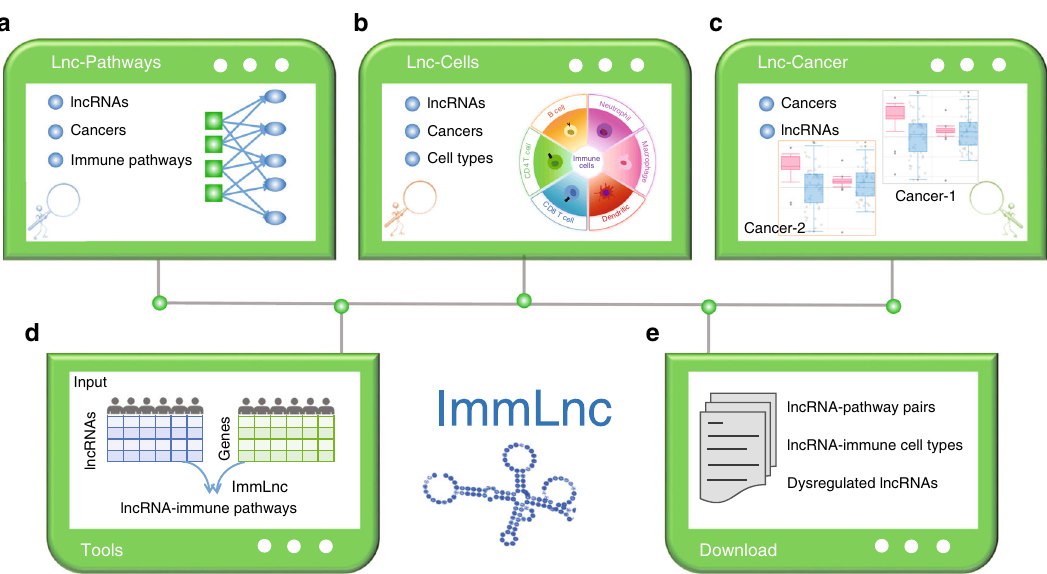
Fig. 7 Diagram of the web-based ImmLnc resource. a The query of immune pathway-related lncRNAs in cancer. b The query of immune cell in fi ltration- related lncRNAs across cancer types. c The query of cancer-related lncRNAs. d The ImmLnc package can be downloaded for local analysis based on paired lncRNA and mRNA expression. e All resources on this website can be downloaded for further